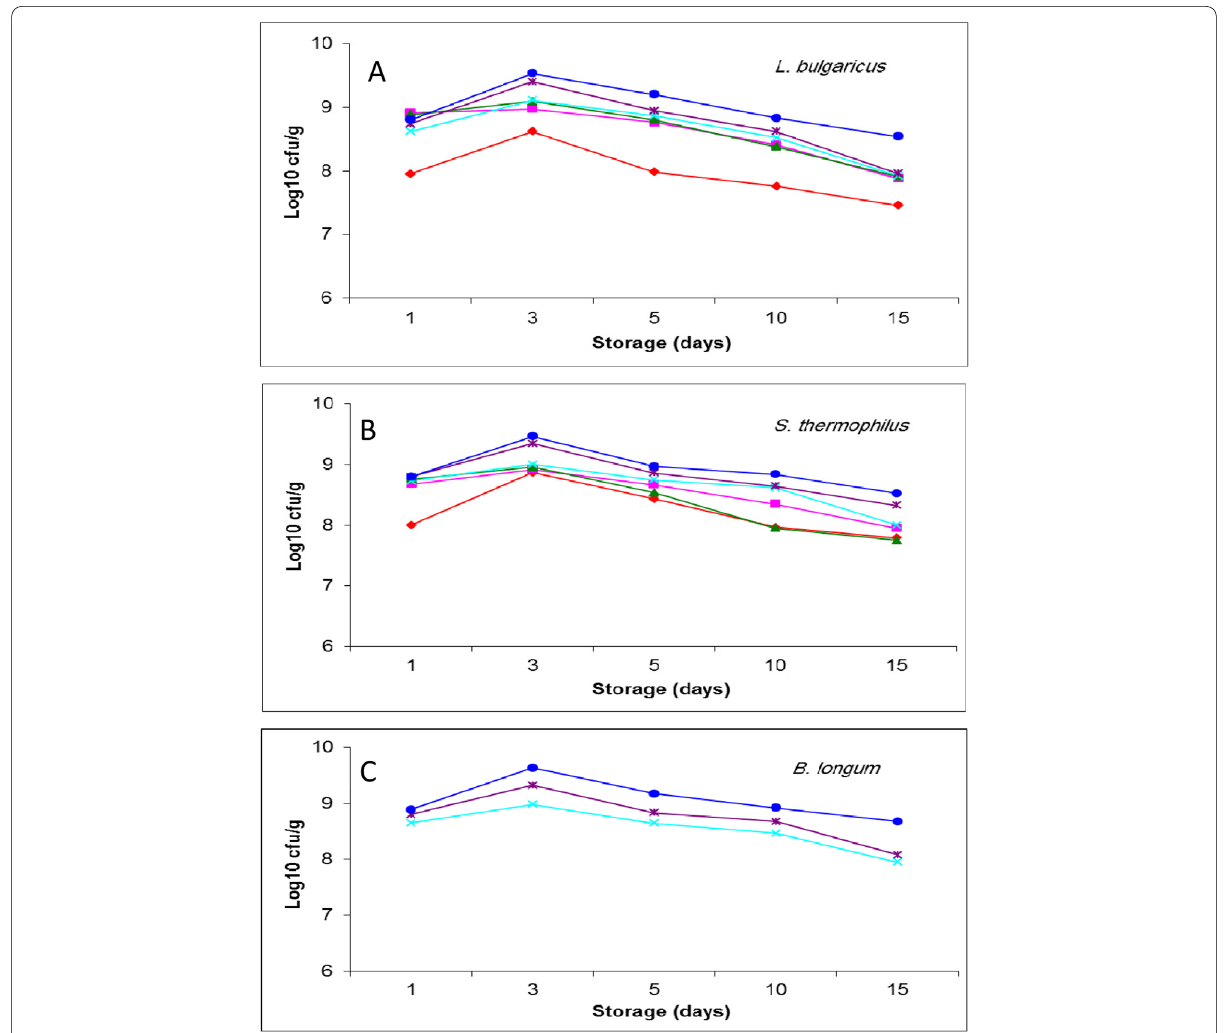
Fig. 1 Changes in viable counts of starter cultures and probiotic bacteria of yoghurt made from ewes’ milk fed a diet supplemented with Spirulina platensis or fish oil during storage at 5 2 °C for 15 ±